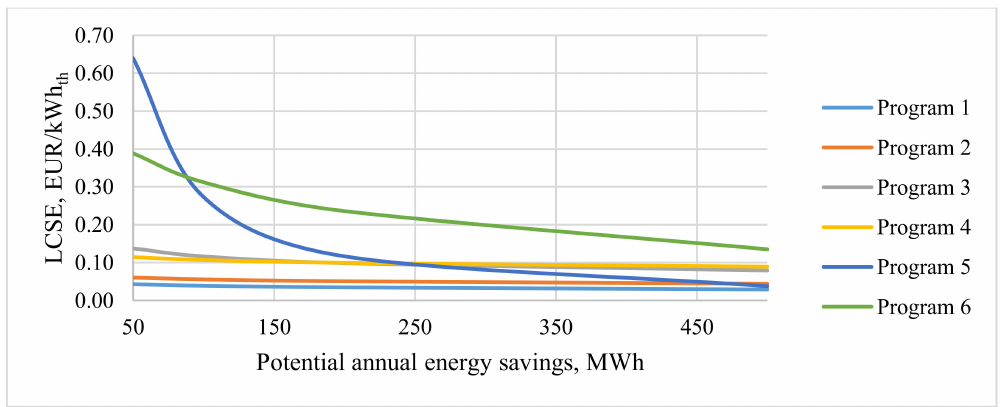
Figure 8. Benchmark of specific costs for energy savings in di ff erent programs.